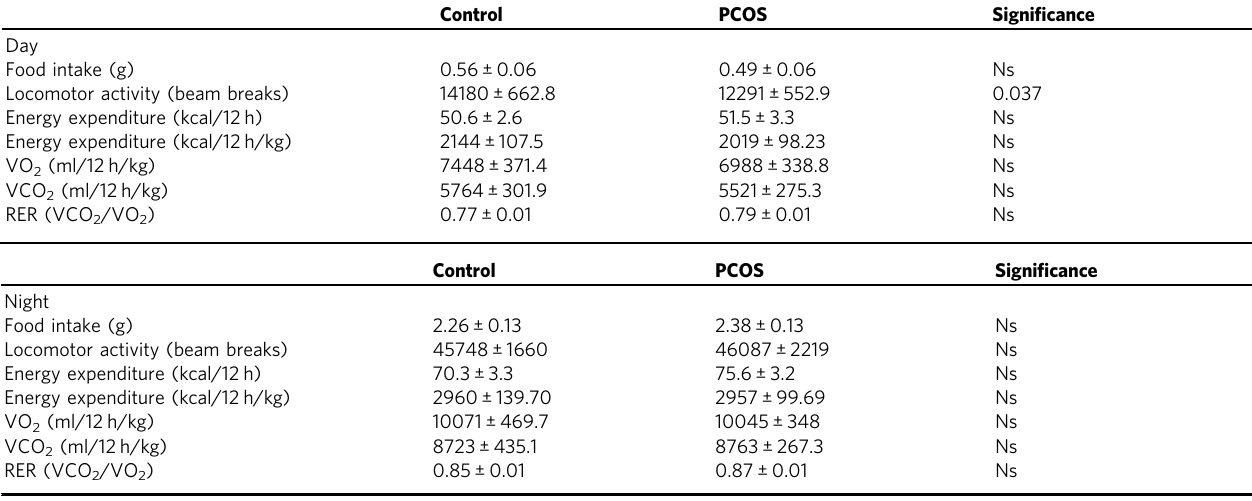
Measurements of indirect calorimetry by metabolic cages of control and PCOS mice on a standard chow diet, showing food intake (g),locomotor activity (beam breaks), energy expenditure (kcal/12h), body weight corrected energy expenditure (kcal/12h/kg), oxygen (O 2 ) consumption (VO 2 ), carbon dioxide (CO 2 ) produced (VCO 2 ), and respiratory exchange ratio (RER) do not differ between control and PCOS mice. Data are the mean±SEM; n = 17 control and 16 PCOS